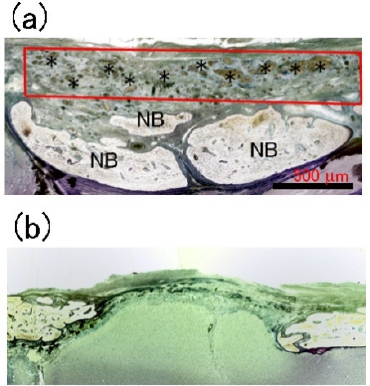
Figure 6. Villanueva-stained histological images of cranial bone defect filled with P-nHAP/COL (( a ): red rectangle) and without implant material (DEF: ( b )) at 8 weeks after surgery. Note: ( a ) Most fragmented P-nHAP/COL remnants (*) existed in the upper half of the cranial defect (red rectangle). NB = newly formed bone. ( b ) Connective tissues alone were seen in the defect gap.